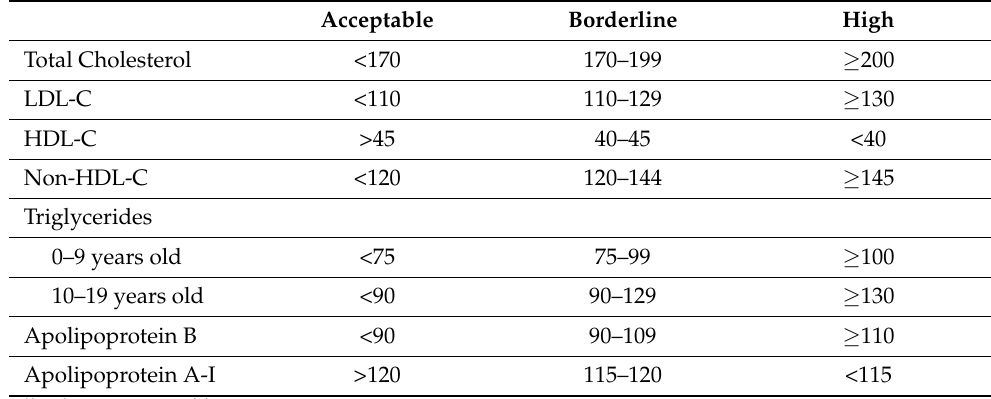
Table 1. Reference Ranges for Pediatric Lipid and Lipoprotein